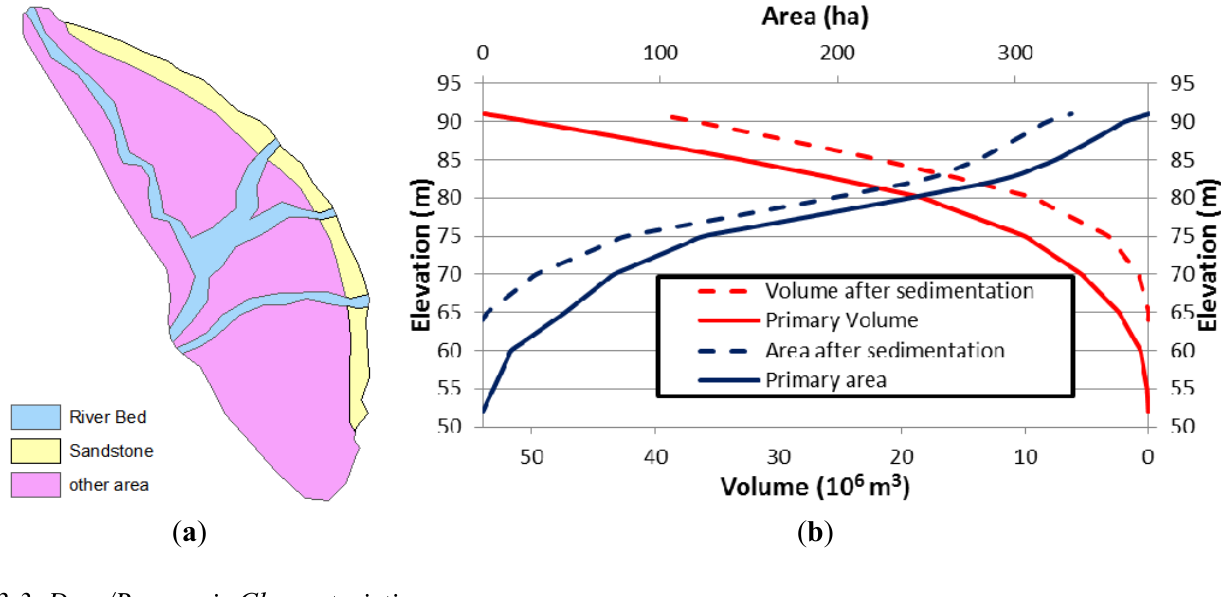
Figure 8. ( a ) Different recharge zones in the aquifer; ( b ) elevation-area-volume graph of Merk dam reservoir before and after